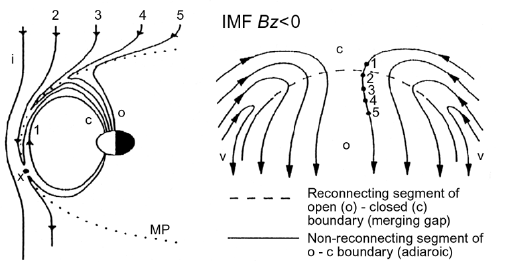
Fig. 13. Magnetic reconnection close to the equato- rial plane and the consequent convection of plasma in the high-latitude ionosphere, driven in an anti-sun- ward flow across the polar cap. From Lockwood (1998), reproduced by permission of the